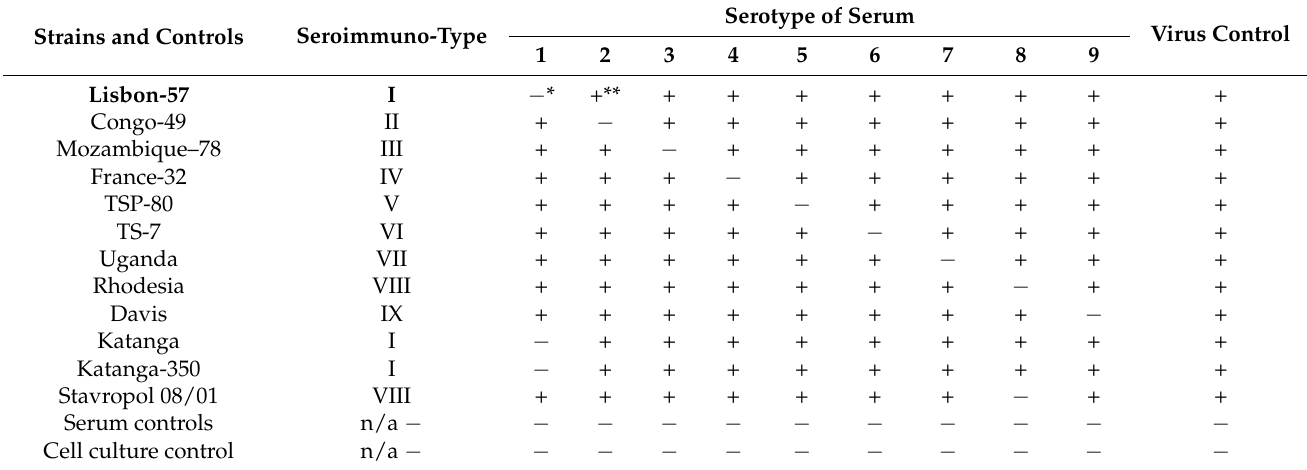
Table 1. Serotyping of ASFV strains in HAdI.